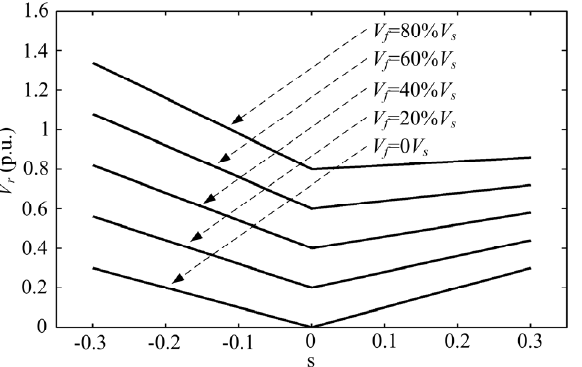
Figure 13. The required output voltage of the RSC under different voltage drop